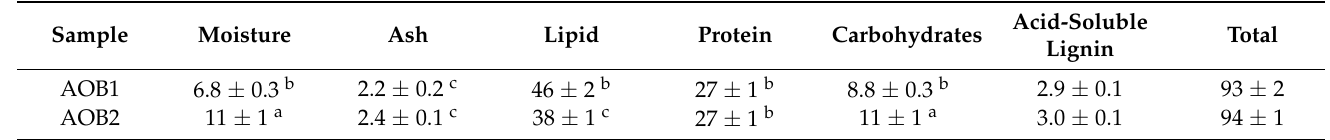
Acid-Soluble Total Lignin